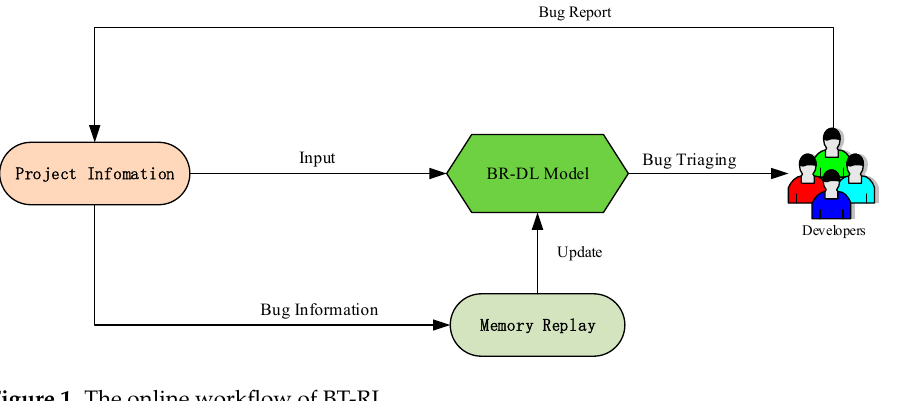
Figure 1. The online workflow of BT-RL.